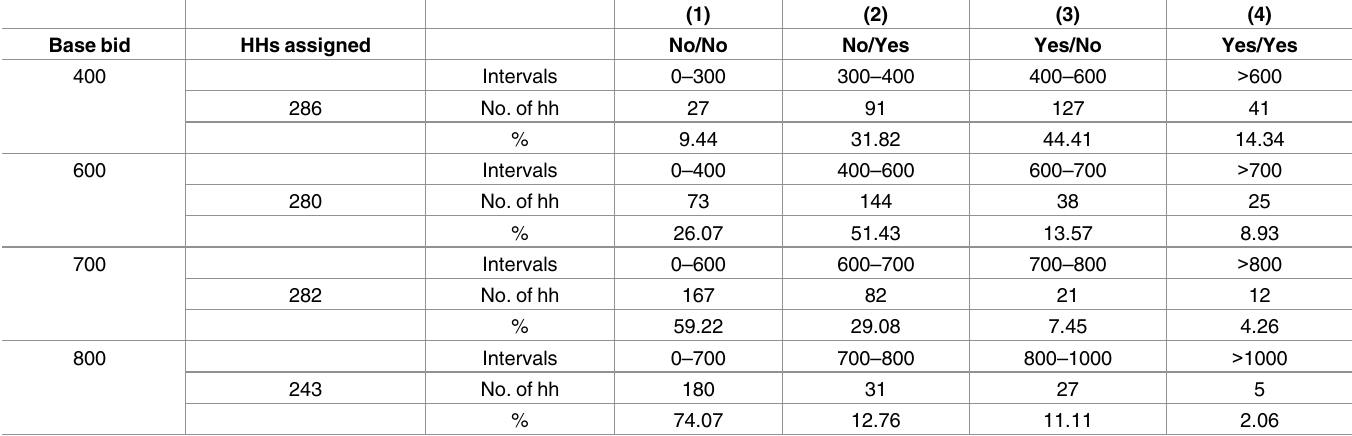
Table 10. Responses to the bid vectors.